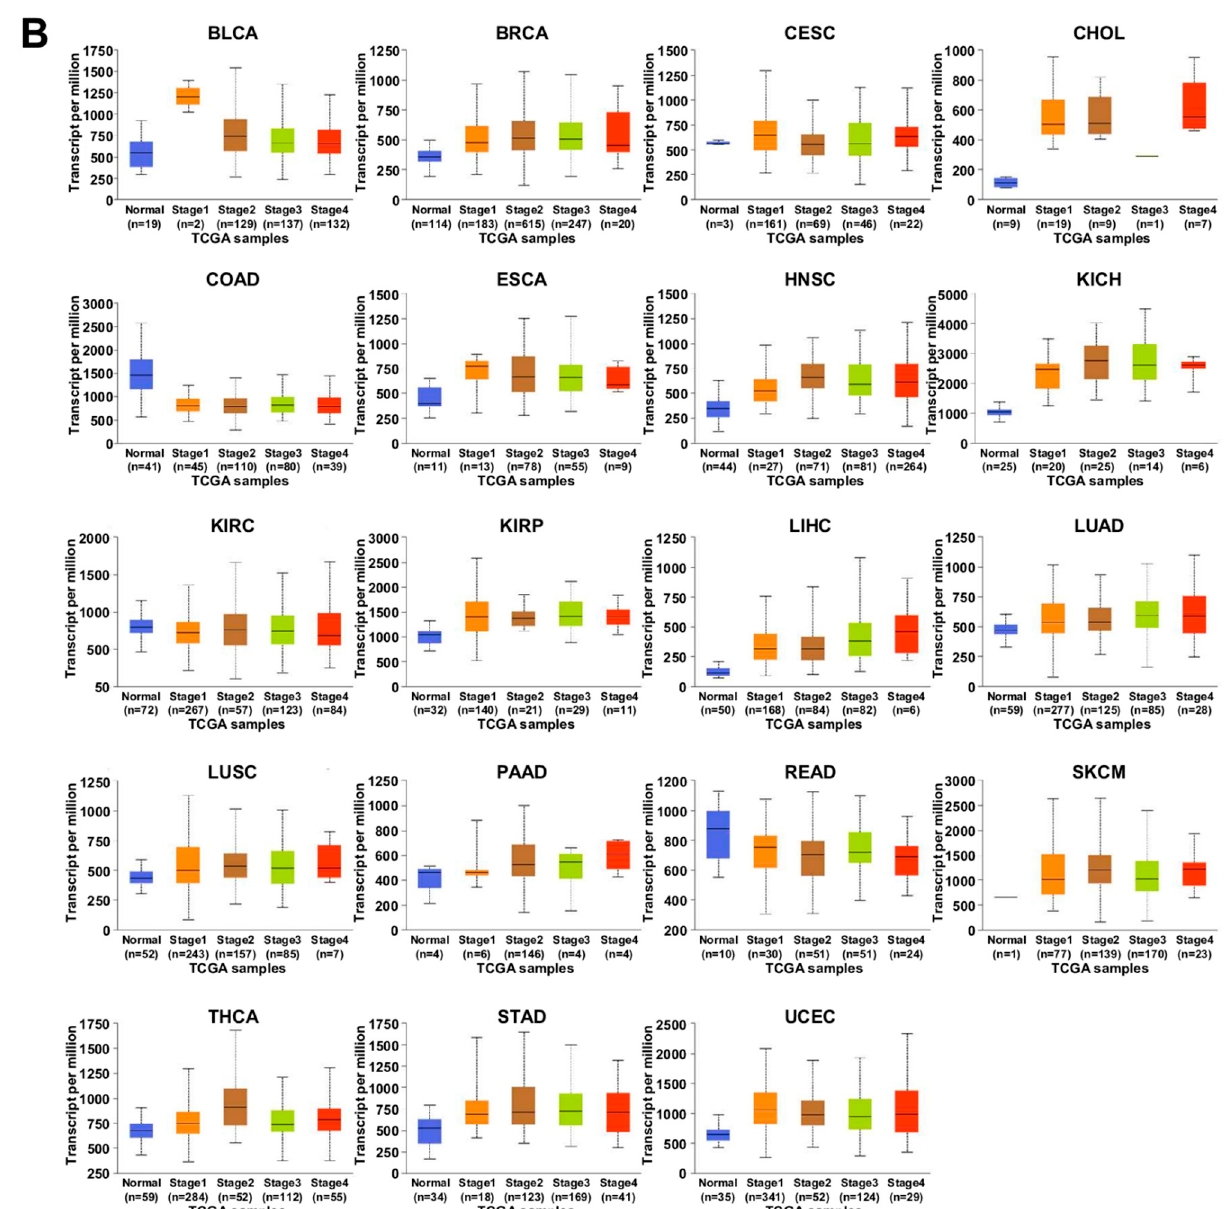
Figure 6. Transcription levels of PPIA and BSG in individual cancer stages (normal, stage 1, stage 2, stage 3, stage 4). ( A ) Expression levels of PPIA . ( B ) Expression levels of BSG . The data were obtained through UALCAN analysis using the TCGA database. The full name of each carcinoma is described in the legend in Figure 5.